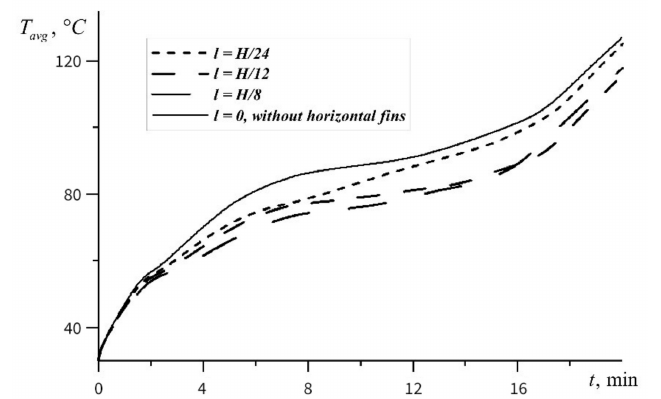
Figure 8. The graph of the dependence of the mean heater temperature on time at Os =